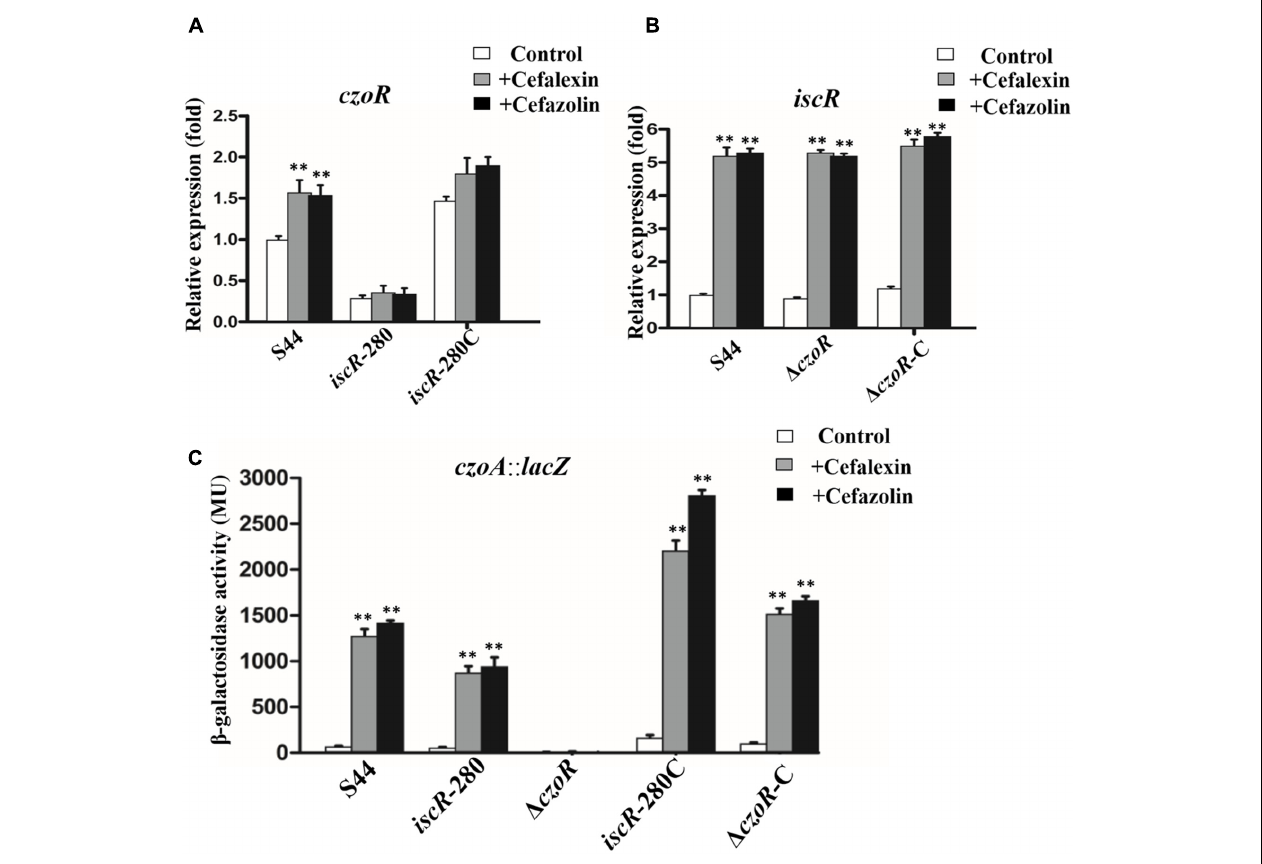
FIGURE 6 | Transcriptional analysis. (A,B) Represents real-time RT-PCR results for czoR and iscR . The relative czoR and iscR mRNA expression levels induced by cefalexin (gray bars) and cefazolin (black bars) and in the control (without induction, white bars) were determined as described in the section “Materials and Methods.” Error bars represent standard deviations of triplicate tests. (C) Shows a lacZ reporter fusion of czoA. Bacteria were cultured in LB medium with or without (white bars) addition of 25 µ g/ml cefalexin (gray bars) and cefazolin (black bars). ∗∗ Indicates a significant difference from the control ( p < 0.01, Student’s t